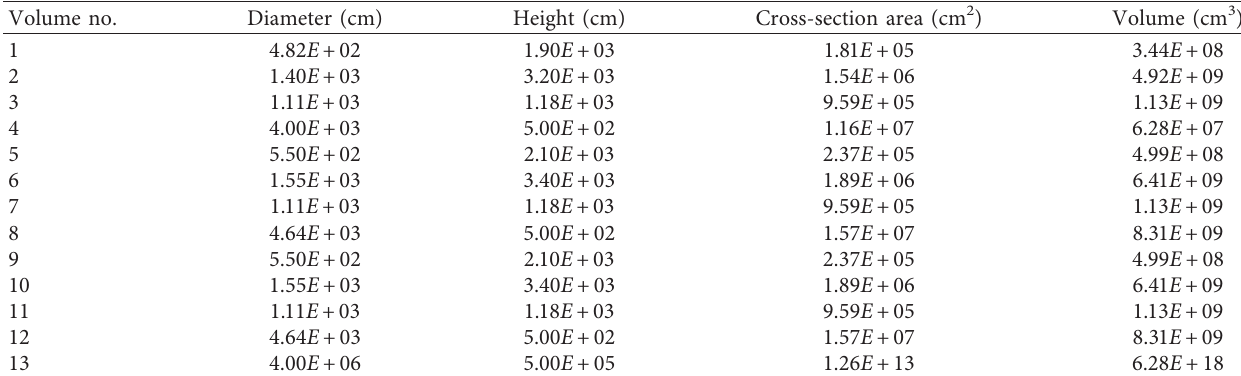
Figure 2: Nodalization and flow directions of case 1 (reference case). Table 1: Inputs for geometry determination in Modified ART Mod 2.